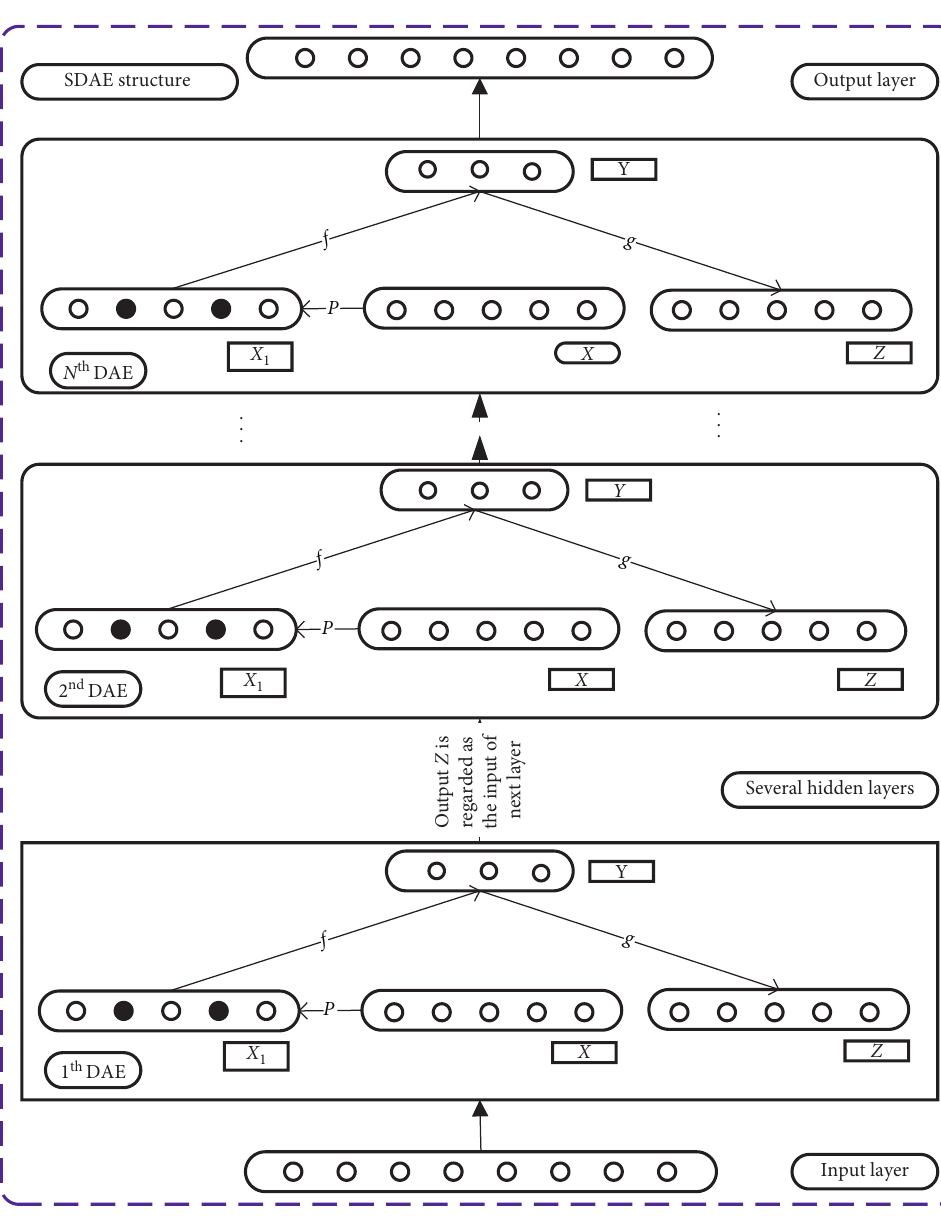
Figure 3: Basic structure of the SDAE.